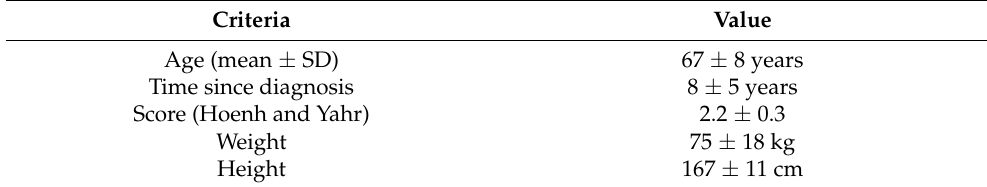
Table 1. A description of the PD population.